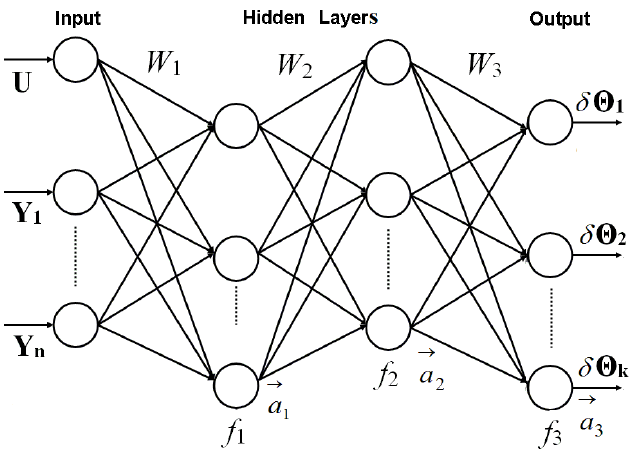
Figure 1. Two hidden layers MLP proposed to develop the GasTurb diagnostic models.